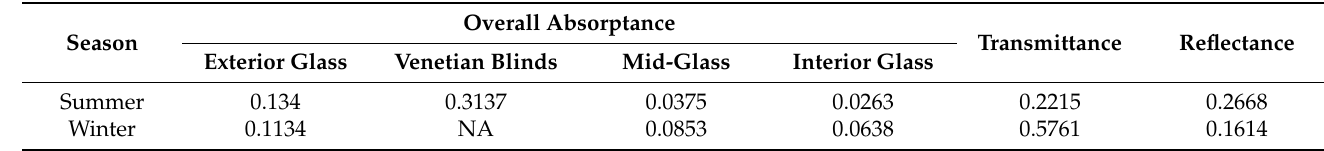
Table 3. Optical properties of the EAGU in cooling and heating seasons [30]. Reprinted with permission from ref. [30]. Copyright 2019 Elsevier.